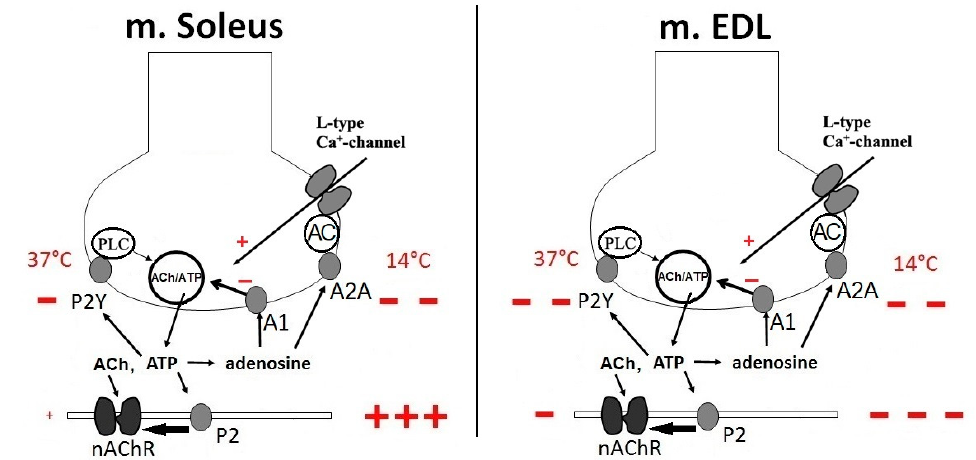
Figure 2. Schematic diagram of purinergic modulation of neuromuscular transmission at soleus muscle (m. Soleus) and extensor digitorum longus (m. EDL) neuromuscular junctions under normothermic and hypothermic conditions. ATP and its metabolite, adenosine, are both involved in separate negative feedback mechanisms: ATP via P2Y receptors and adenosine via adenosine A 1 and A 2A receptors. A synaptic vesicle in the nerve terminal is shown, filled with ATP in addition to the primary neurotransmitter, acetylcholine (ACh). Exocytosis of the vesicle contents causes activation of ATP pre- and post-synaptic P2 receptors. At 14 °C the pre- and post-junctional effects become more pronounced. The signs “+” and “ − ” show the direction of action of ATP: +, facilitating neuromuscular transmission, − , inhibiting neuromuscular transmission. Doubling and tripling of signs means, respectively, two- and three-fold more pronounced effects. The size of the signs themselves also indicates a relative magnitude of the effects. PLC—phospholipase C; AC—adenylate cyclase.